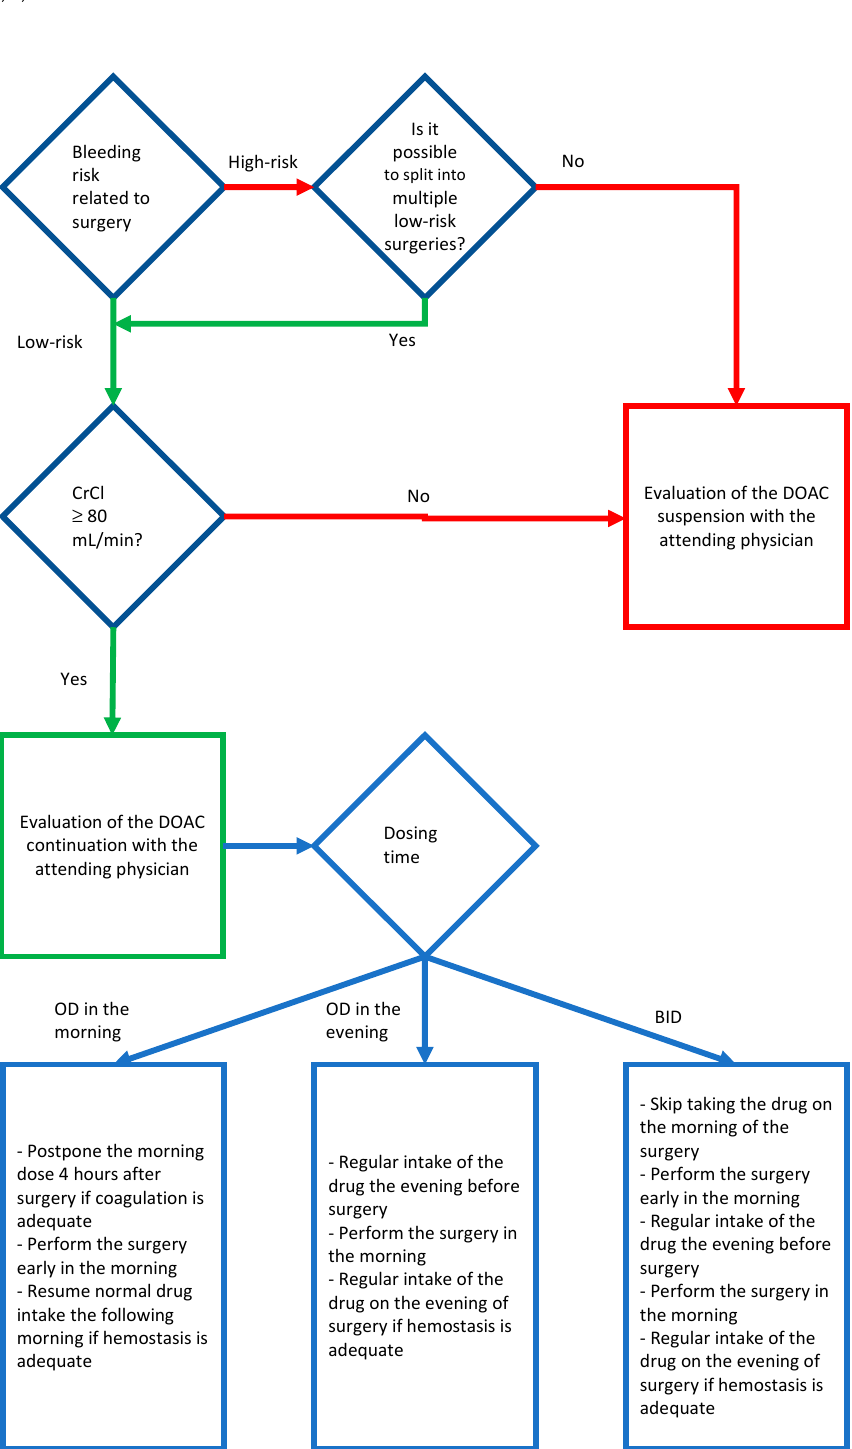
Figure 1. Scheme for the evaluation of the peri-operative maintenance of anticoagulant therapy.